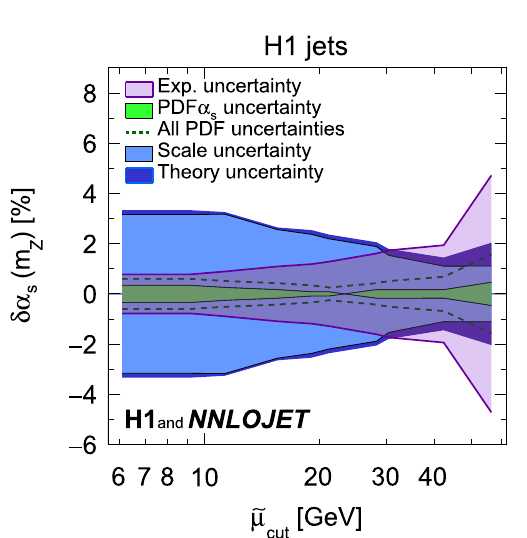
Fig. 9 Values of α s ( m Z ) obtained for different definitions of the renormalisation and factorisation scales ( μ R and μ F ) in the H1 jets fit (left) and the H1 jets fit with ˜ μ > 28GeV (right). The open circles display results obtained using NLO matrix elements. The vertical bars indicate the scale uncertainties displayed together with the nominal scale choice